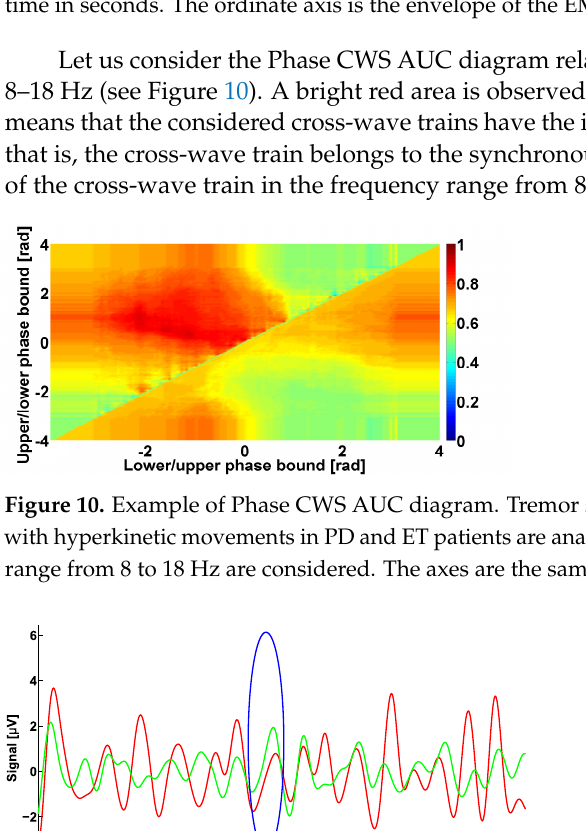
Figure 9. Example of the cross-wave train in frequency range from 4 to 6 Hz. Envelopes of EMG signals in antagonist muscles of left arm with hyperkinetic movements in a first-stage PD patient are given. The signals from the flexor and extensor muscles are indicated in green and red, respectively. Cross-wave train is indicated by a blue ellipse. The cross-wave train has the following characteristics: central frequency is 5.3 Hz, power spectral density (PSD) is 142.30 µ V 2 / Hz, duration is 1.39 periods, frequency bandwidth is 0.9 Hz, and instantaneous phase is − 3.02 radians. The abscissa axis is the time in seconds. The ordinate axis is the envelope of the EMG signal in µ V.